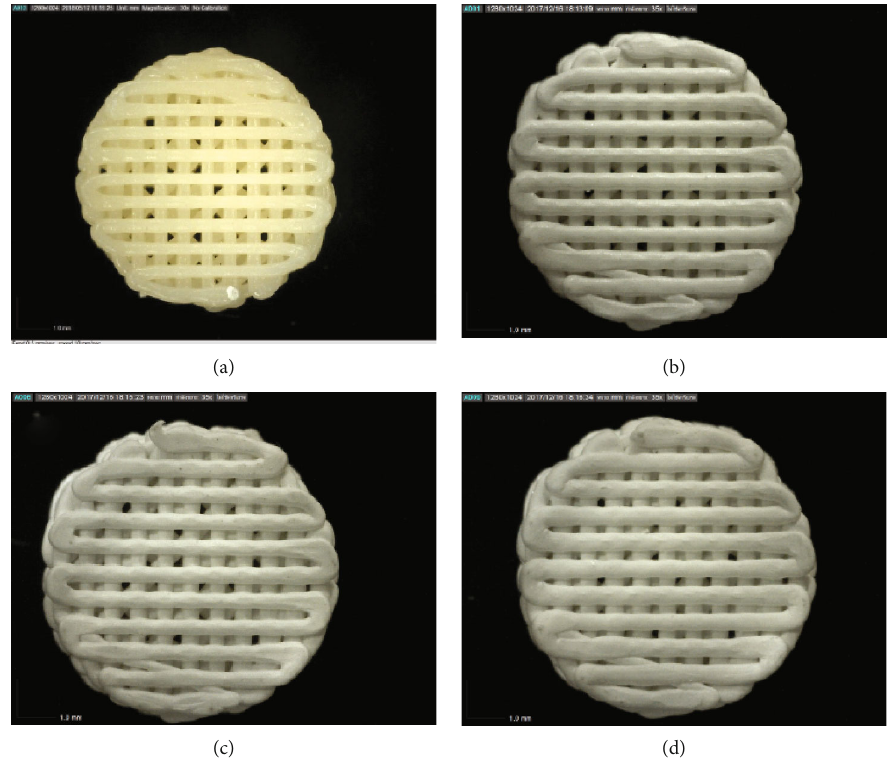
Figure 7: Sca ff olds of (a) 50NaCl_25/75 before removing of salt, (b) 50NaCl_0.5H25/75, (c) 50NaCl_1H25/75, and (d) 50NaCl_3H25/75 PCL/PHBV.